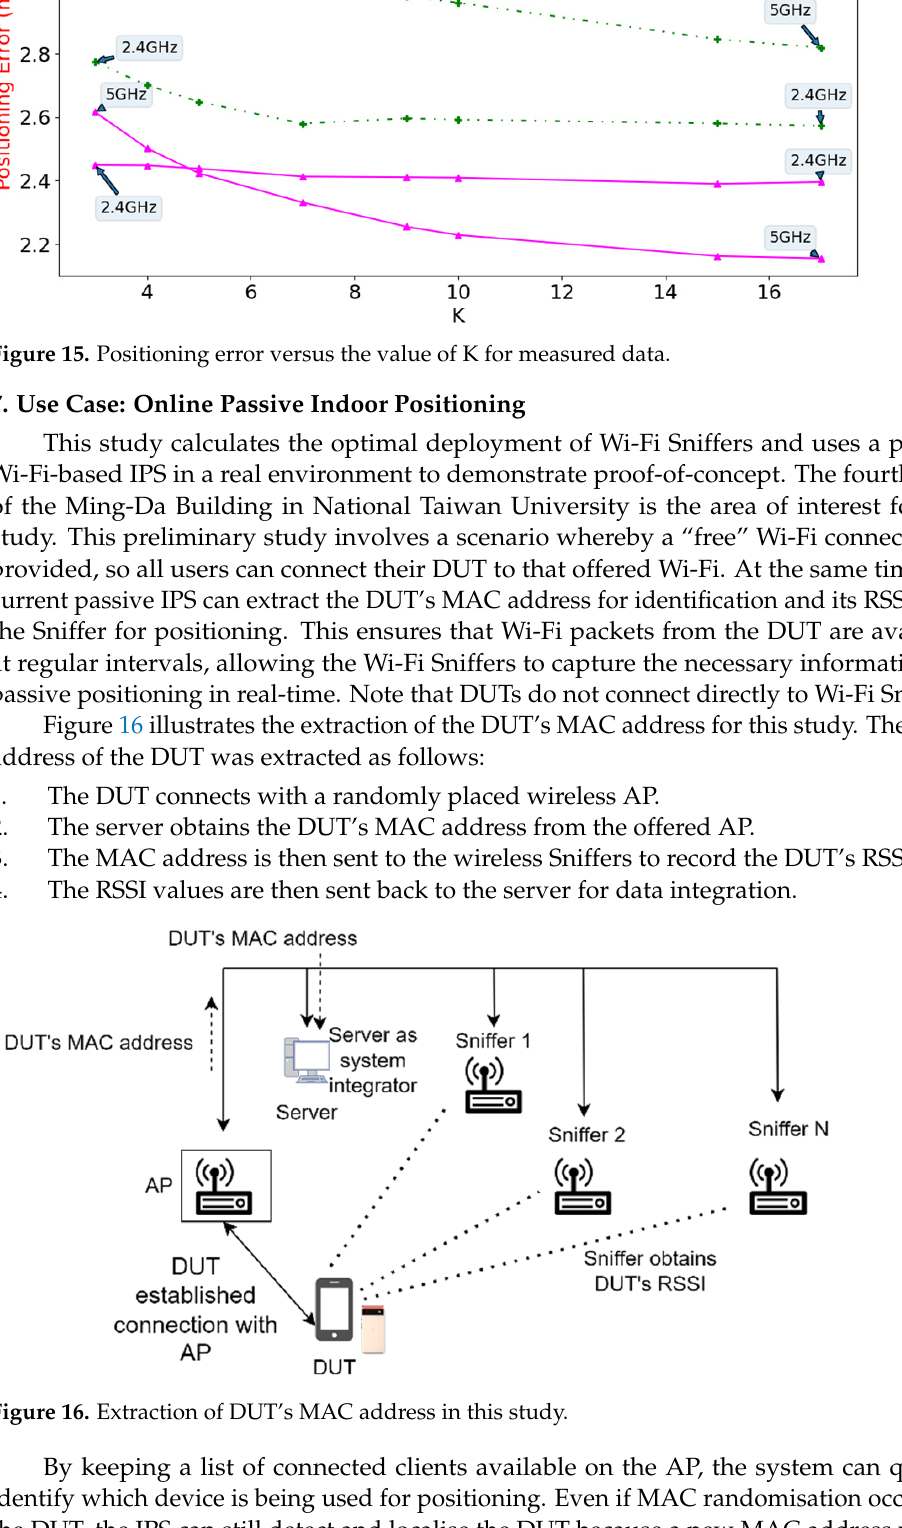
Figure 14. Positioning error versus the value of K for simulated data.